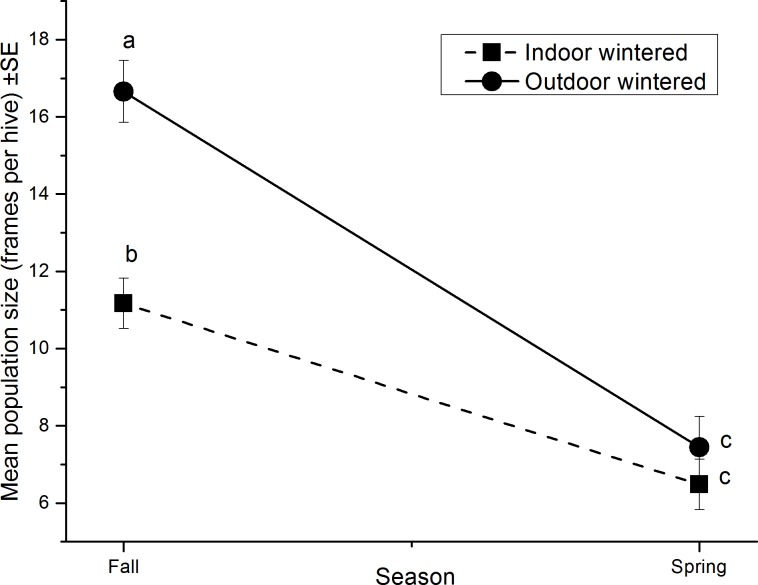
Change in colony population score (frames of bees, 1 frame = ~ 2,430 bees) from fall to spring, for indoor (-■-) and outdoor (─●─) wintered colonies.Means followed by the same letter are not significantly different (P > 0.05; Bonferroni).